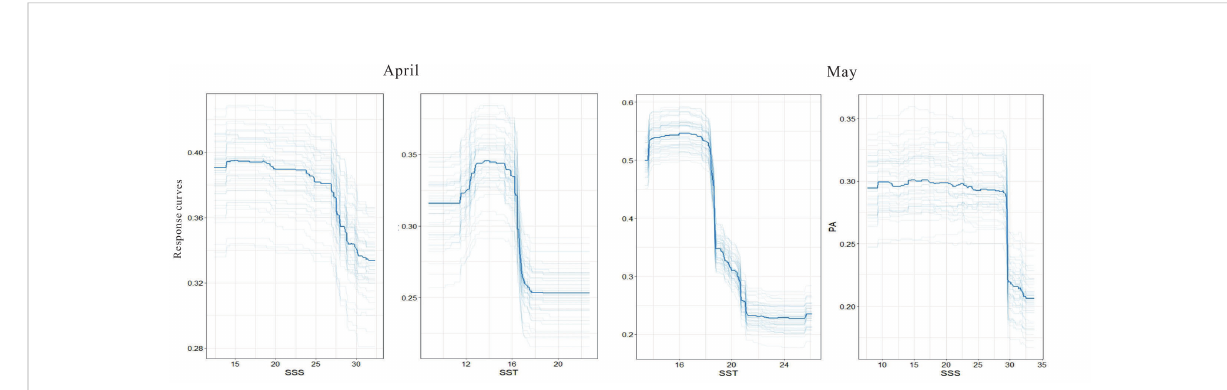
FIGURE 4 Response curves for the two most related environmental factors on the egg distribution of the small yellow croaker from April to May by repeating the SDM execution 50 times. The bold solid line is the median response curve, and the light solid line is the response curve obtained by repeating each